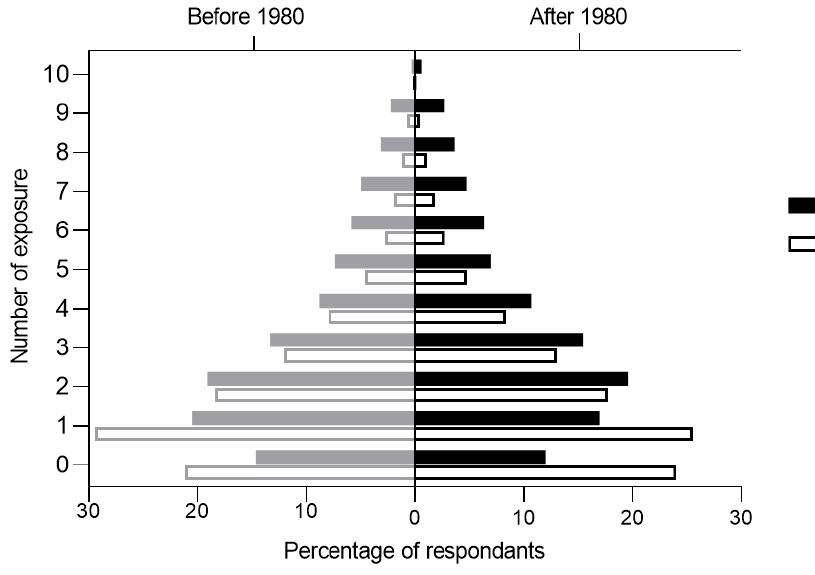
Figure 4. Number of workplace hazards comparing shift and other workers.